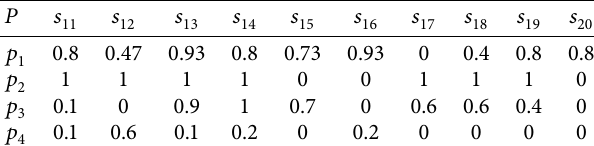
Table 13: Tabular representation of ( F, S ) part 1.